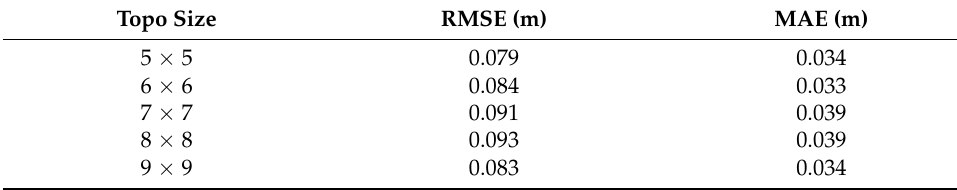
Table 4. Determination of SOM in sub-region S3.